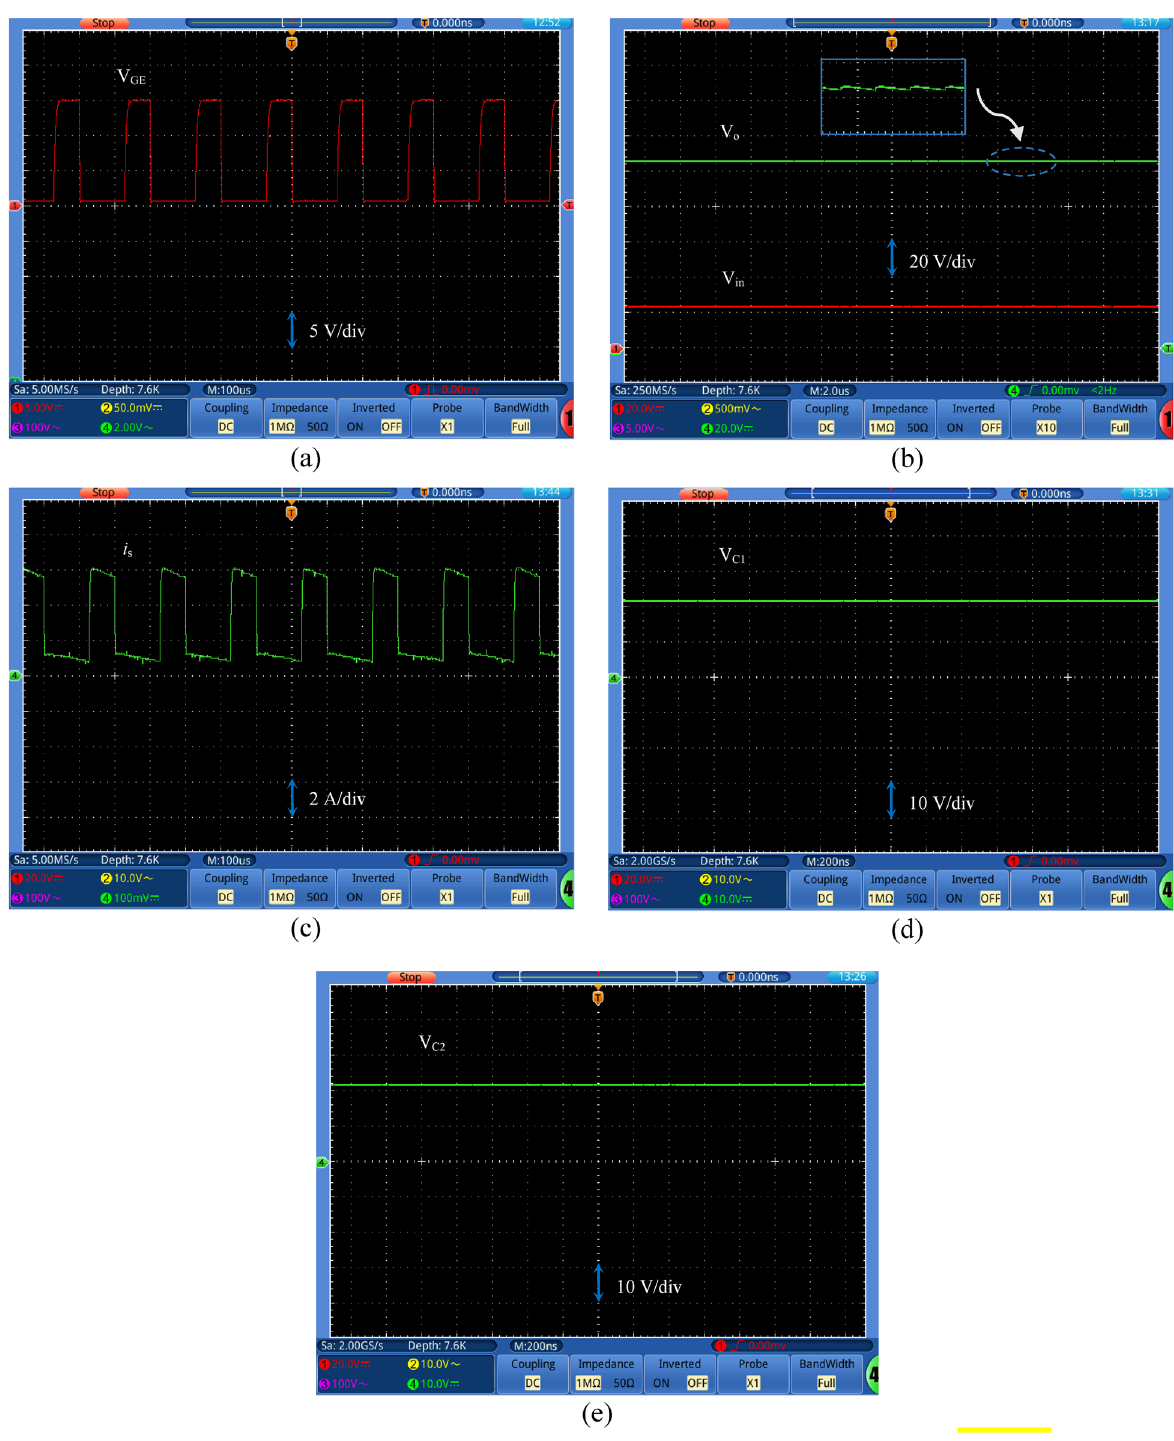
Figure 10. Experimental waveforms of ( a ) gate-emitter voltage, ( b ) input and output voltage, ( c ) input current, ( d ) capacitor C 1 voltage, and ( e ) capacitor C 2